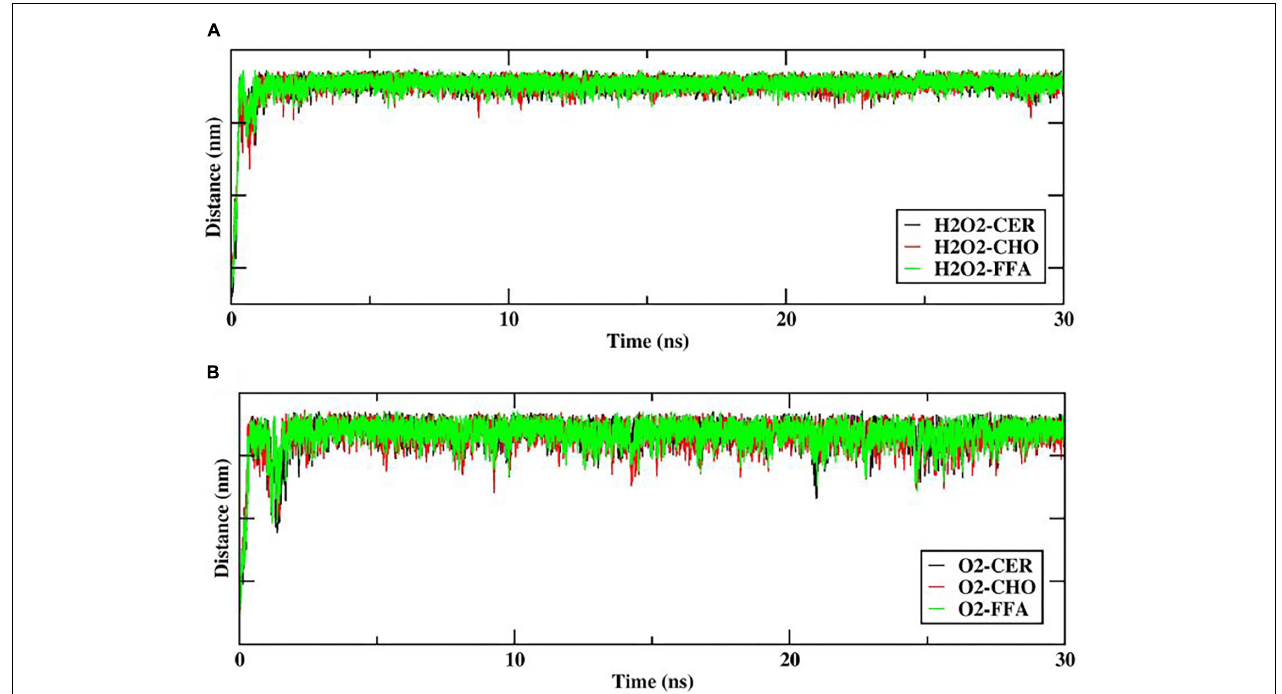
FIGURE 5 | Distance between reactive oxygen species (ROS) (A) hydrogen peroxide (H 2 O 2 ), (B) O 2 , and headgroups of upper skin-lipid bilayer components (CER-CHO-FFA) as a function of time (ns).